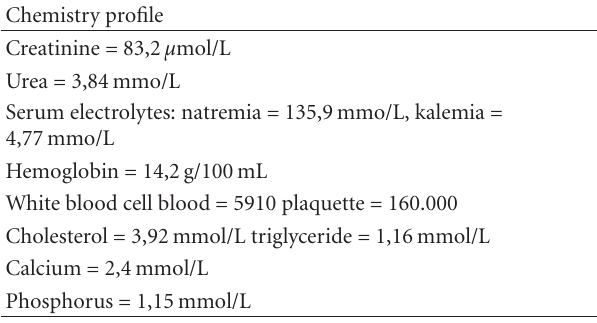
Table 1: Chemistry profile of our patient.